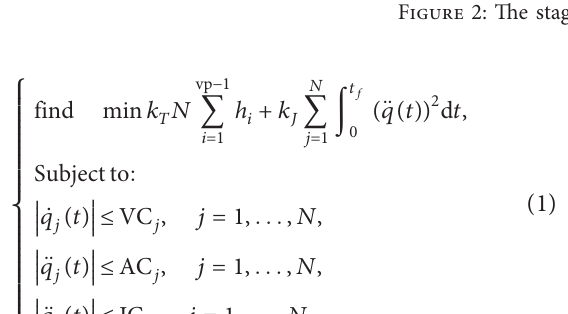
Figure 2: The stages of the joint